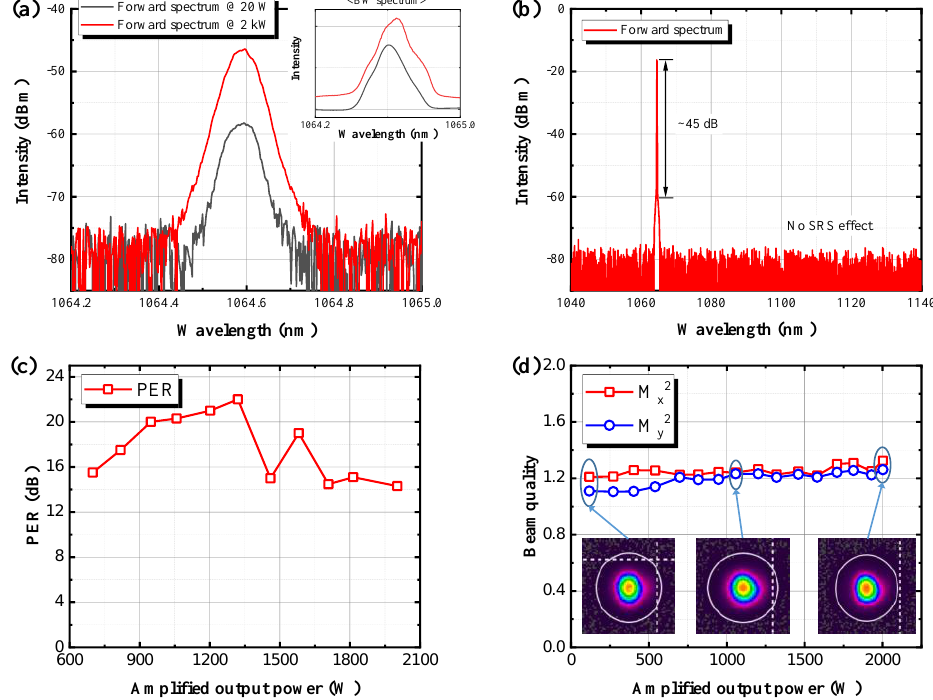
Figure 4. The measured output characteristics: ( a ) forward and backward (inset) beam spectrum; ( b ) forward output spectrum in a wide wavelength range at the maximum output power; ( c ) PER; ( d ) beam quality. The temporal trace of the forward output beam was measured to monitor the TMI effect. Applying Fourier transform on the temporal traces to calculate the corresponding Fourier spectrum, we obtained the frequency distribution of the output beam stability in the range of 0~400 Hz at the maximum output power, as shown in Figure 5, which means that no TMI was found during the power scaling process in this amplifier [40,41].